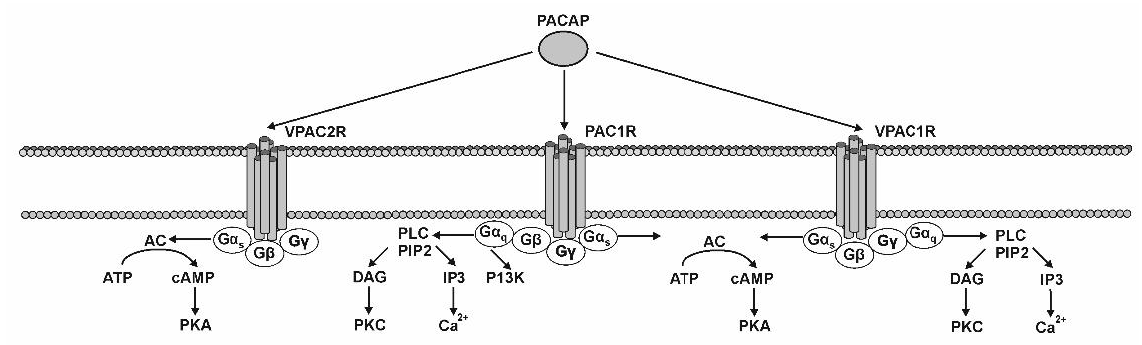
Figure 1. PACAP receptors (PAC1R, VPAC1R, and VPAC2R) and their biological action. cAMP- cyclic adenosine3′,5′ - monophosphate; AC-adenylate cyclase; PKA-protein kinase A; ATP- adenosine triphosphate; Gα/β/γ -G protein al- pha/beta/gamma subunit; PLC-phospholipase C; PIP2-phosphatidylinositol 4,5-bisphosphate; DAG-diacylglycerol; IP3- inositol trisphosphate; PI3K-phoshoinositide 3-kinase. The figure is based on the graphics contained in the article of Ga- briel et al. [40].